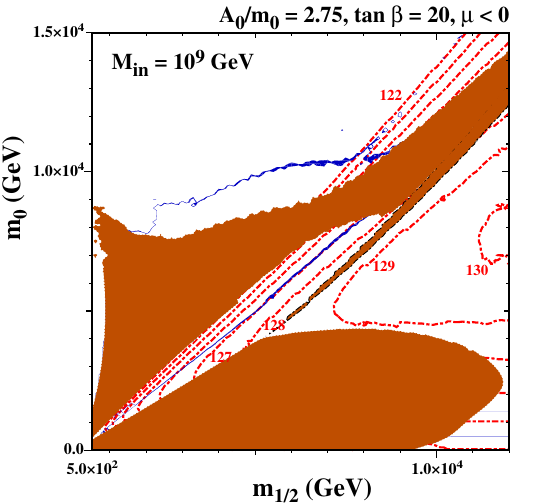
the 3 σ Planck range 0 . 1151 < (cid:12) h 2 < 0 . 1235 [37] is used. Regions where the LSP is charged are shaded brick red and contours of M h are indicated by red dot-dashed lines